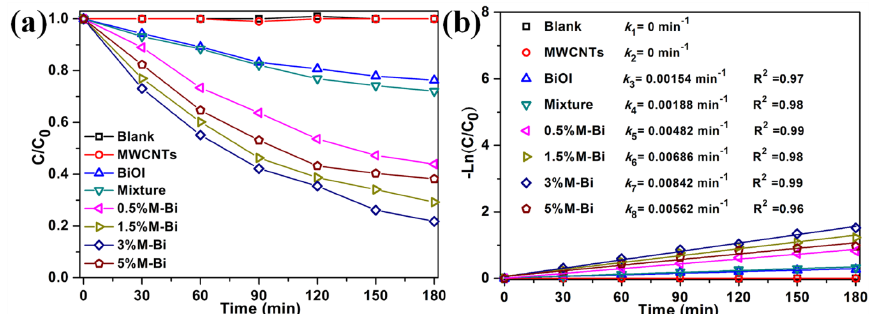
Figure 7. The degradation efficiencies ( a ) and rate constants ( b ) of para -chlorophenol (4-CP) in aqueous solution (1 mg · L − 1 , 50 mL) versus the exposure time under visible light ( λ > 400 nm), in the absence of catalysts and in the presence of as-prepared catalysts (10